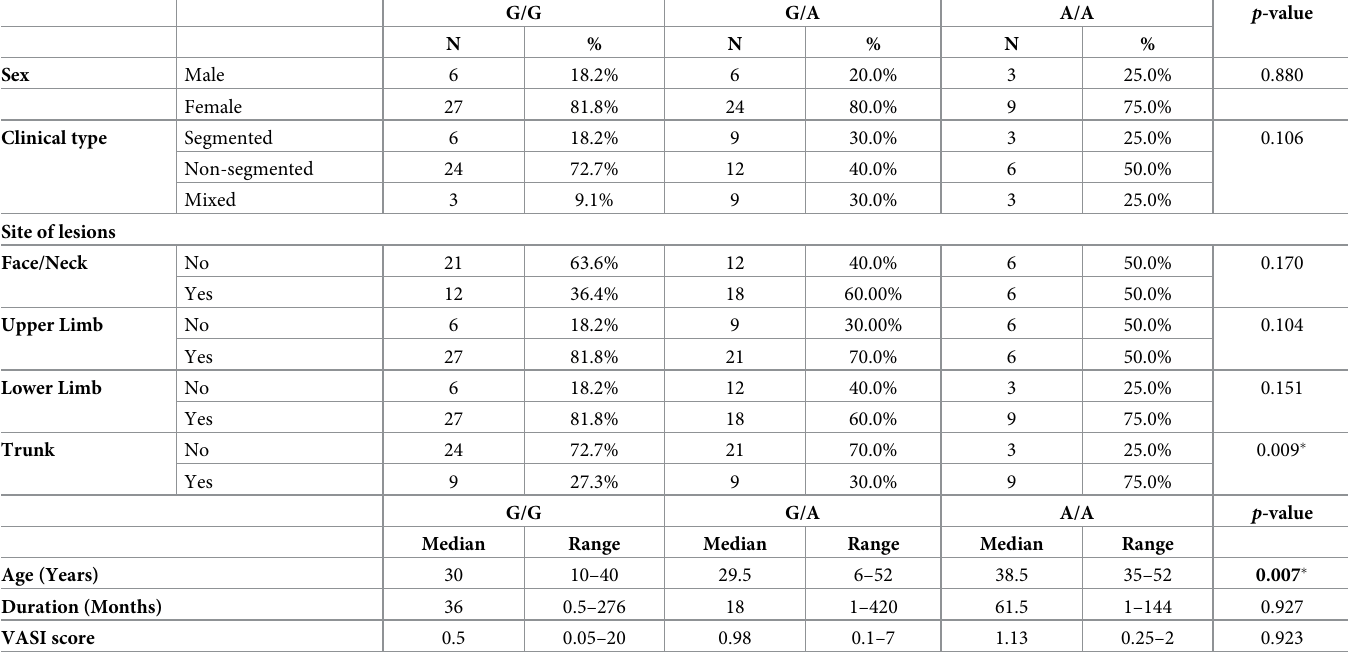
Table 6. Relation between TNF- α -308- G/A and clinical characteristics in vitiligo